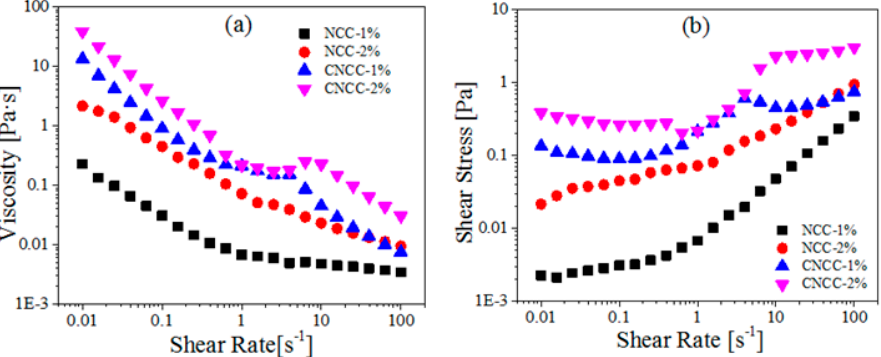
Figure 7. ( a ) Viscosity and ( b ) Shear stress as a function of shear rate for NCC and CNCC suspensions at different concentrations (1, 2 wt %).